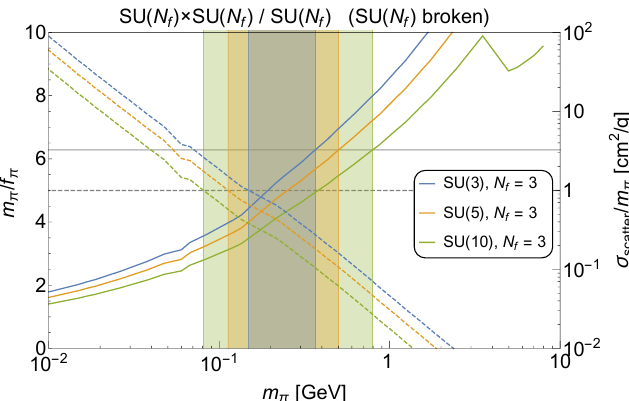
Figure 6: Reproduced from [ 14 ] . Solid curves: the solution to the Boltzmann equation of the 3 → 2 system, yielding the measured dark matter relic abundance for the pions, m π / f π as a function of the pion mass (left axis). Dashed curves: the / m self-scattering cross section along the solution to the Boltzmann equation, σ π scatter as a function of pion mass (right axis). All curves are for selected values of N and N , c f shown here for an SU( N ) gauge group with broken SU( N ) flavor symmetry. The c f solid horizontal line depicts the perturbative limit of m π / f π (cid:174) 2 π , providing a rough upper limit on the pion mass; the dashed horizontal line depicts the bullet-cluster and halo shape constraints on the self-scattering cross section, placing a lower limit on the pion mass. Each shaded region depicts the resulting approximate range for m π for the corresponding symmetry